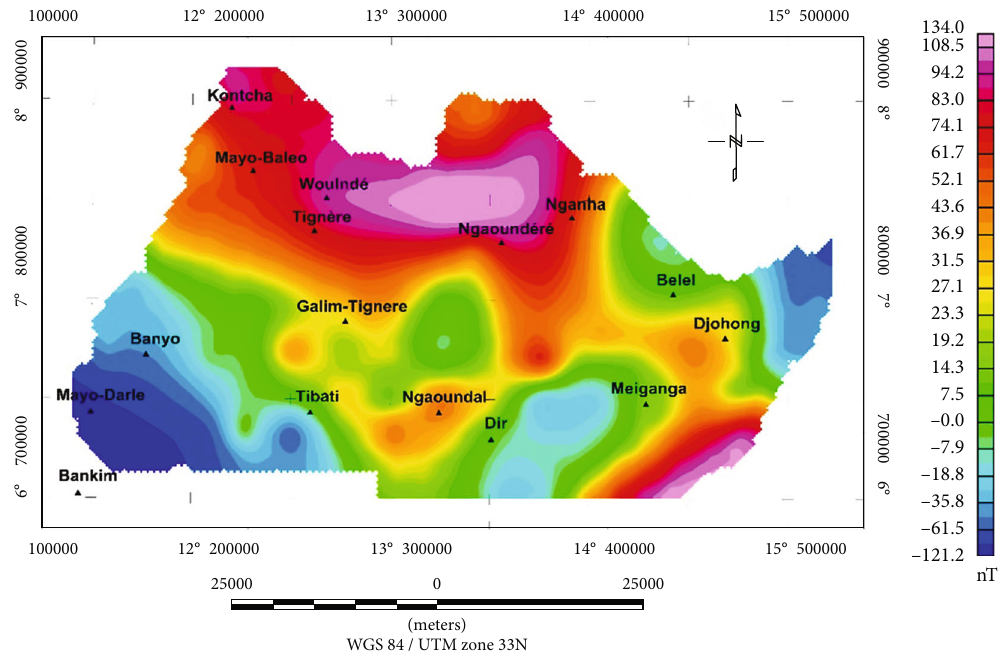
Figure 2: Anomaly map from total magnetic intensity (TMI) of Adamawa